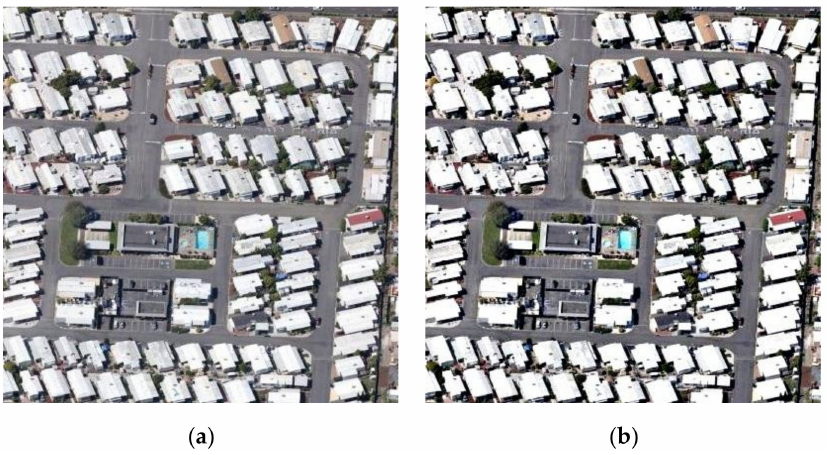
Figure 4. ( a ) Original image. ( b ) Improved image using Gaussian